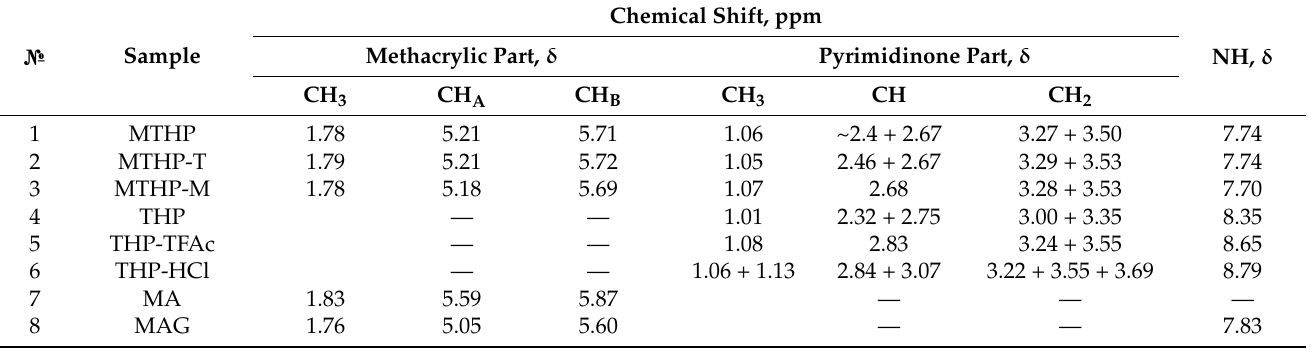
Table 3. 1 H NMR spectral characteristics in DMSO-d 6 of MTPH, TPH, its salts, methacrylic acid (MA) and MAG 1 (Figures